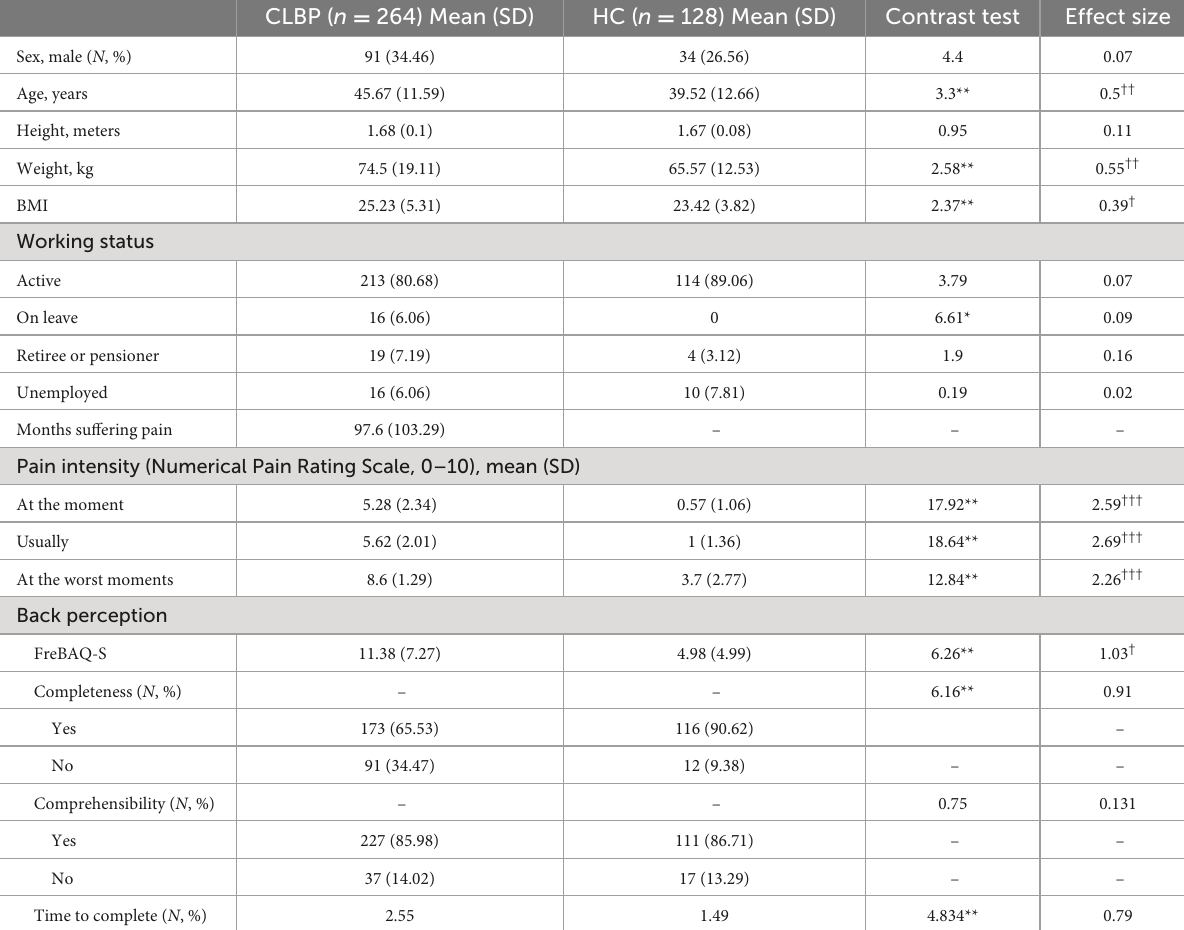
TABLE 1 Sociodemographic and clinical self-reported